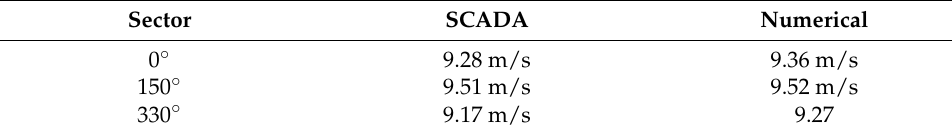
Table 4. Average measured and simulated wind speed: high wind